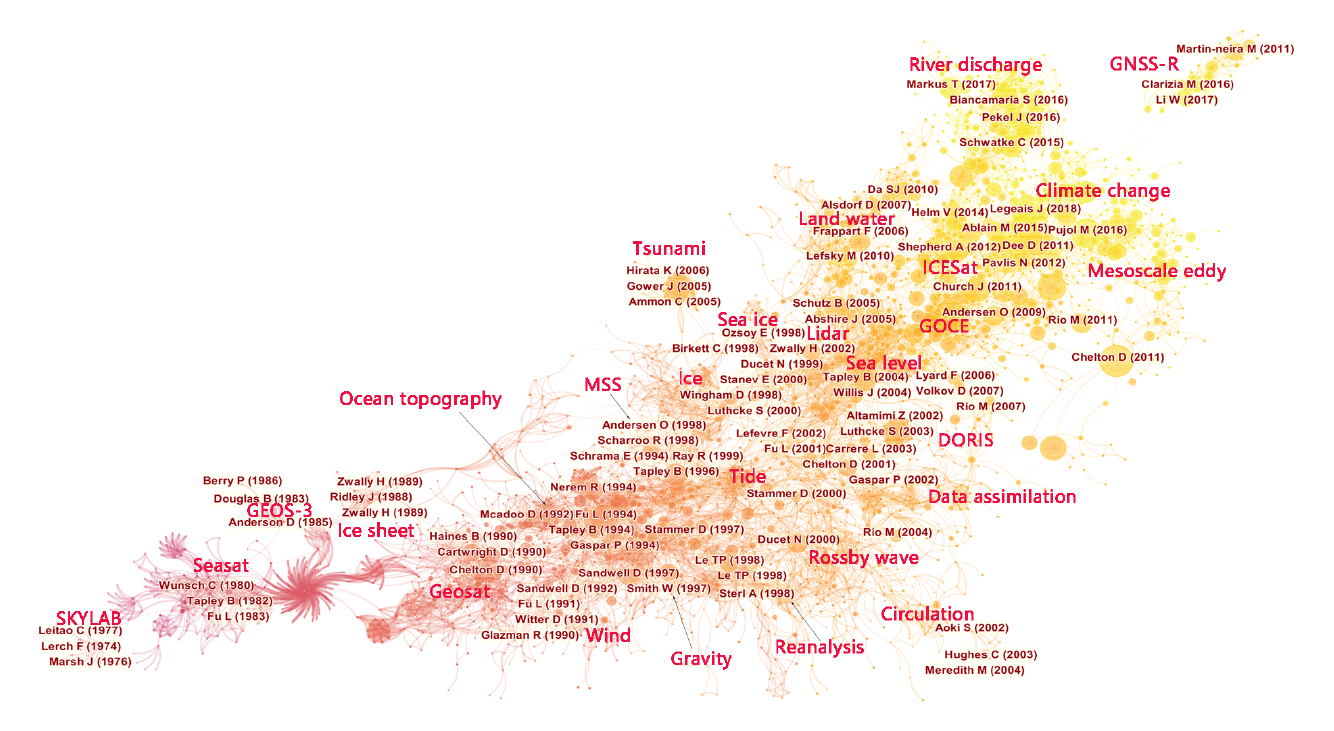
Figure 9. The co-citation network for the satellite alimetry dataset, inclusive of cluster labels and core references. Figure was created by Citespace with configuration: years per slice to 1, select 10% of the most cited items from each slice and maximum number of selected items per slice to 100. Network: 2426 references and 10,350 co-citation